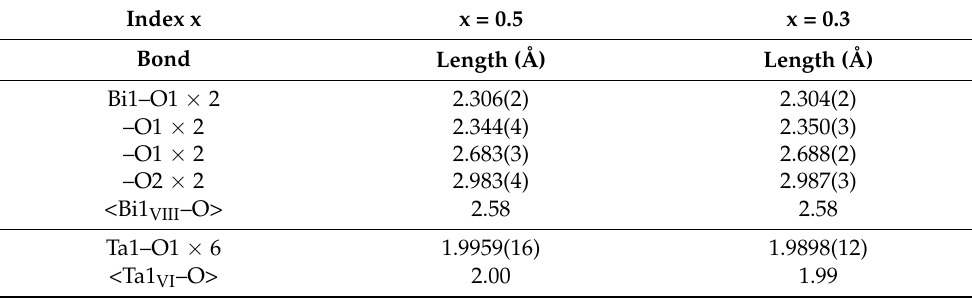
Table 3. Selected bond lengths in the structure of Bi 2 Mg x Fe 1 − x Ta 2 O 9.5 − ∆ .